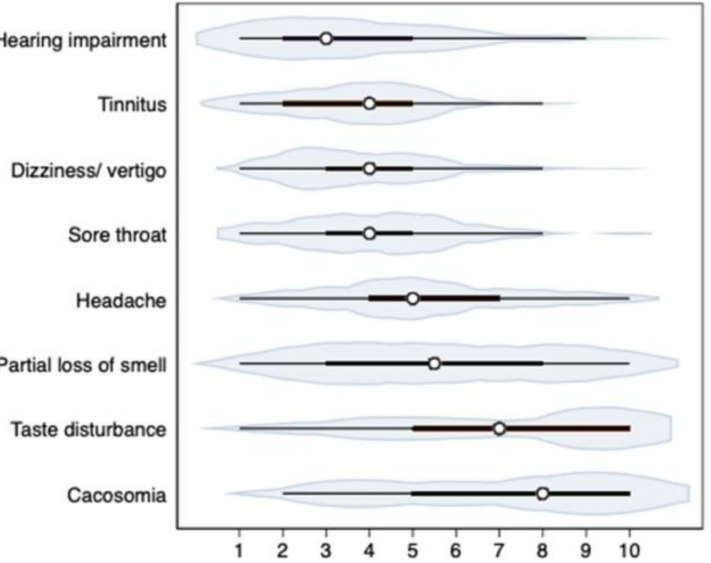
Figure 1. Severity of ENT symptoms assessed on the VAS scale (1–10). Note . The violin plots show medians (points), interquartile ranges (thick horizontal lines), ranges of 95% of observations (thin horizontal